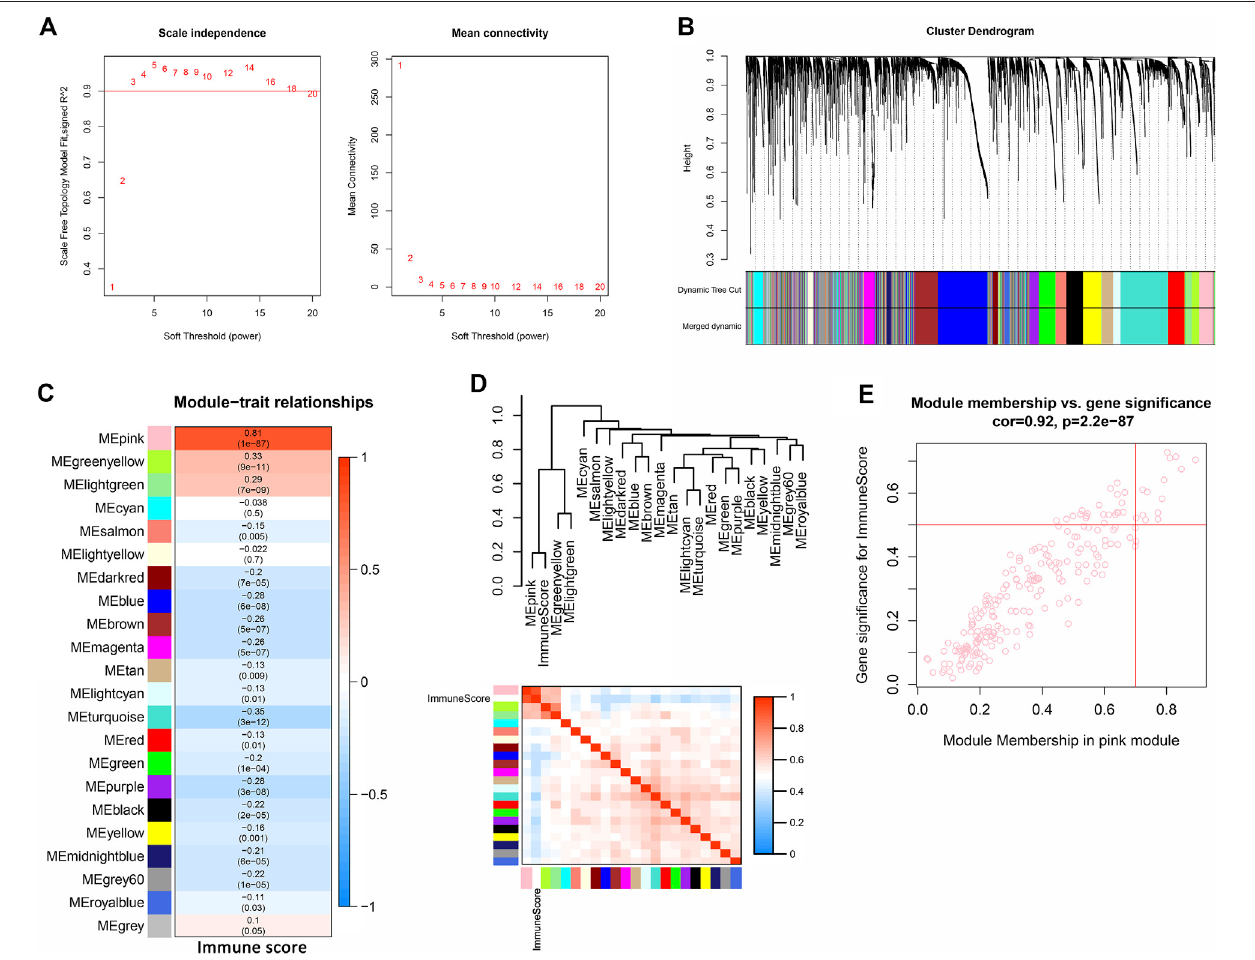
FIGURE 1 | Identi fi cation of immune-related module and key genes of OV. (A) Graphs of scale independence, mean connectivity and scale-free topology, the appropriate soft-power was 3. (B) Cluster dendrogram of the co-expression network modules (1-TOM) (C) Analysis of correlations between the modules and immune scores, p -values are shown. (D) Cluster plot analysis of the relationship between immune scores and modules. (E) Scatter plot analysis of the pink module. Key genes were screened out in the upper-right area where GS > 0.5 and MM > 0.7 (TOM, topological overlap matrix. GS, gene signi fi cance. MM, module membership).